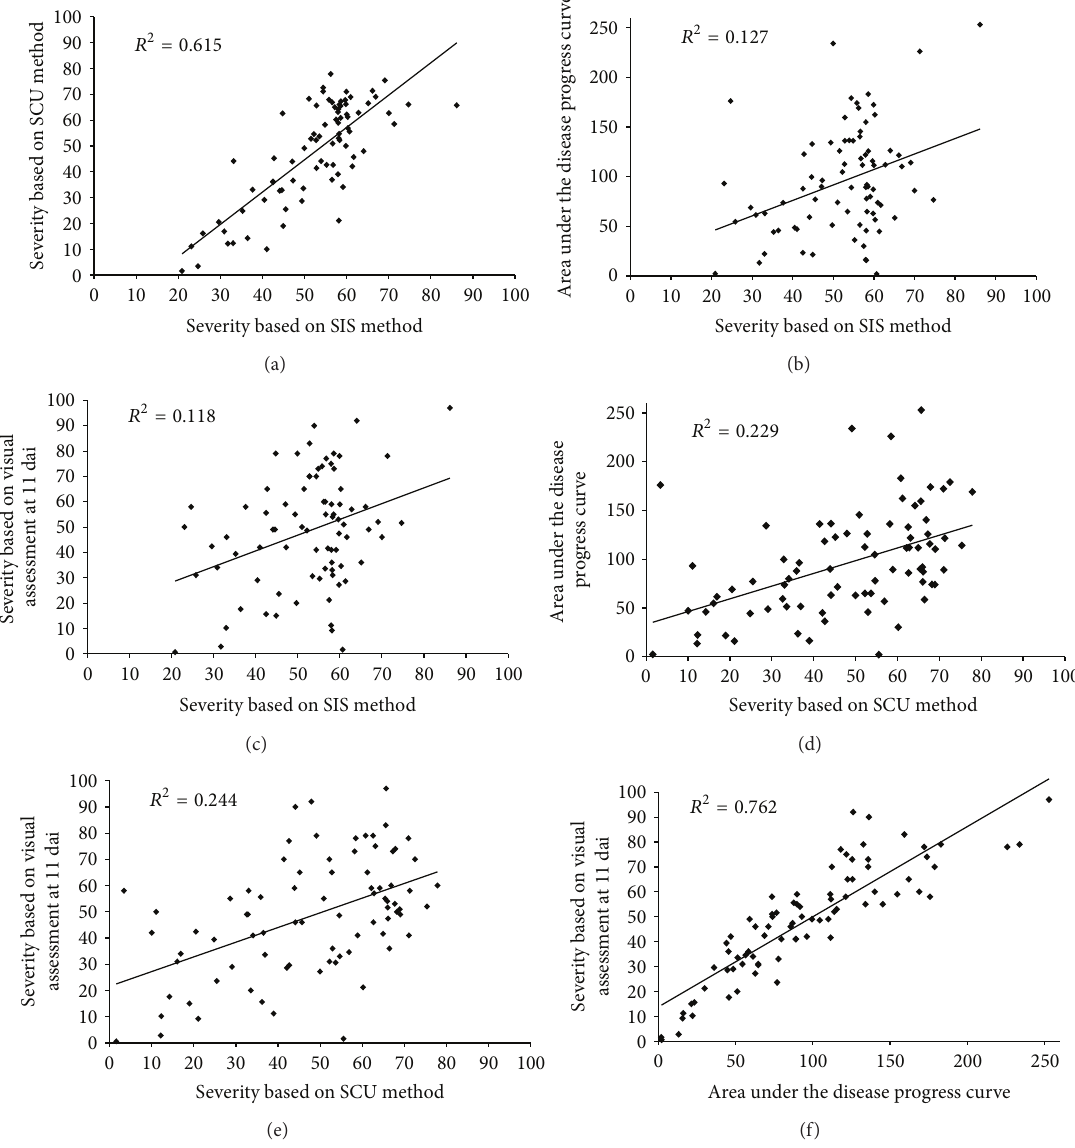
Figure 2: Regression analysis between methods of assessing blast severity on rye and triticale spikes ((a)–(f)). SCU: selection of symptomatic areas with mouse cursor; SIS: selection of symptomatic areas by image segmentation; dai: days after